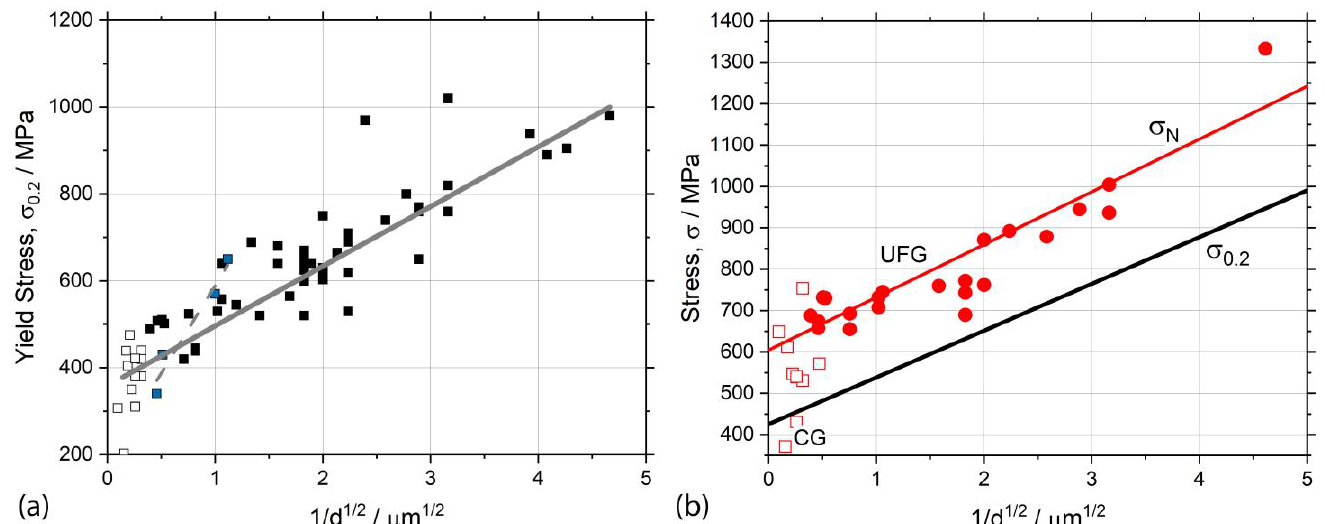
Figure 2. Hall–Petch plots showing the grain size dependence of ( a ) the yield stress σ 0.2 and ( b ) the true stress at maximum load σ N for CP titanium (Grade 2); the data were collected from